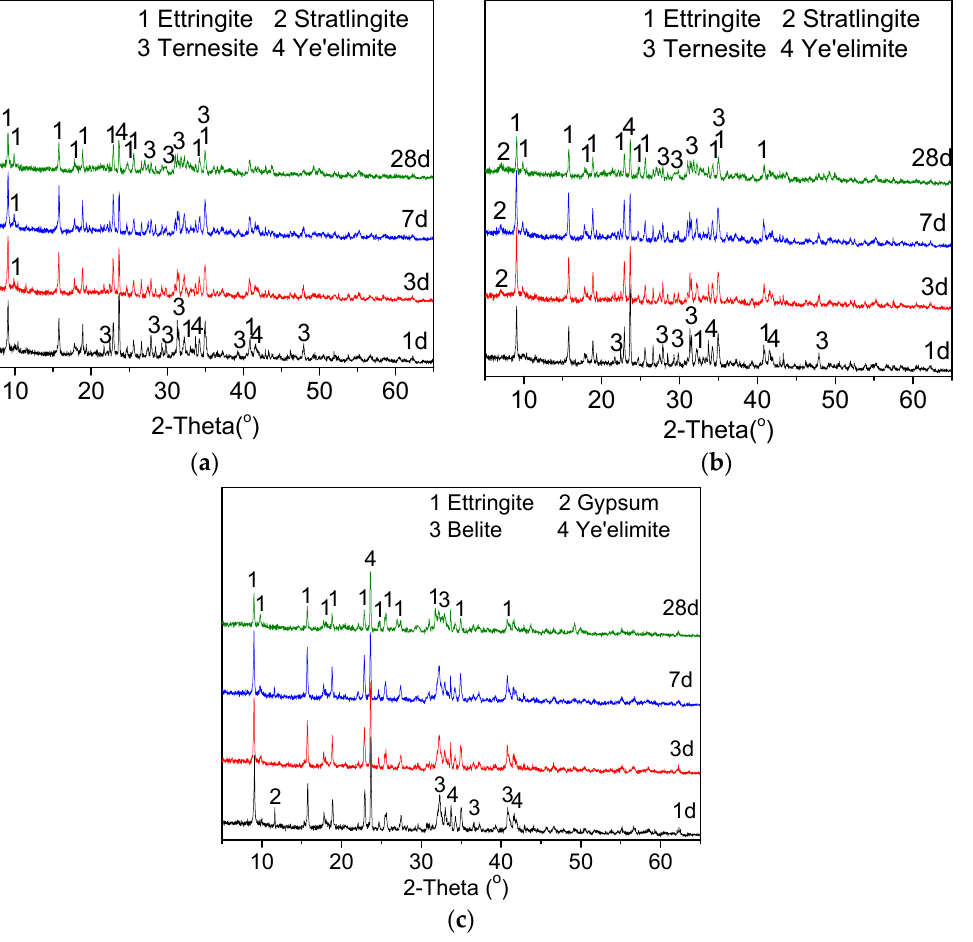
Figure 11. XRD patterns of TCSA and BCSA cement pastes at 1, 3, 7 and 28 days. ( a ) TCSA cement (no dopants); ( b ) TCSA cement (0.3% Na 2 O); ( c ) BCSA cement (no dopants).